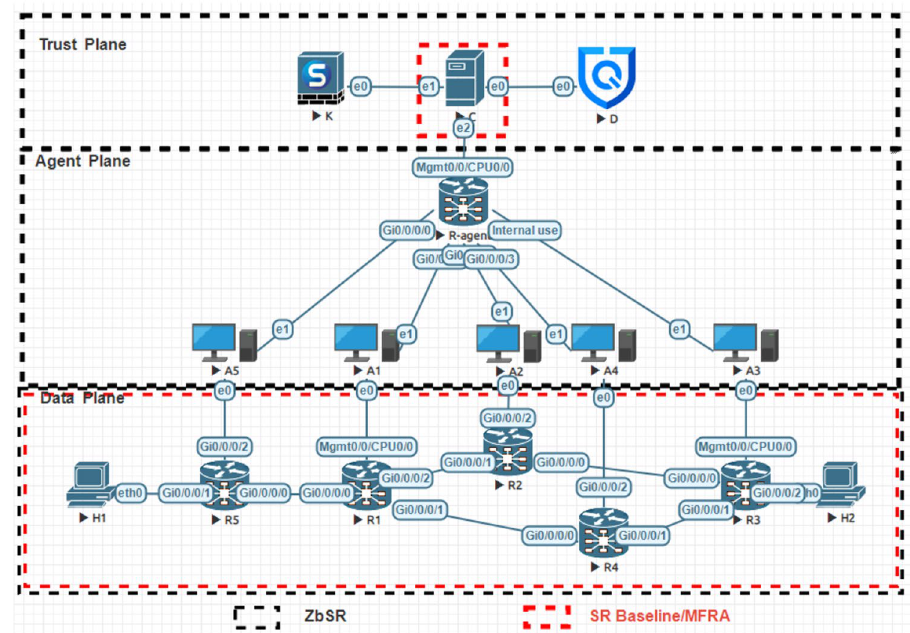
Figure 9. Simulation network topology.